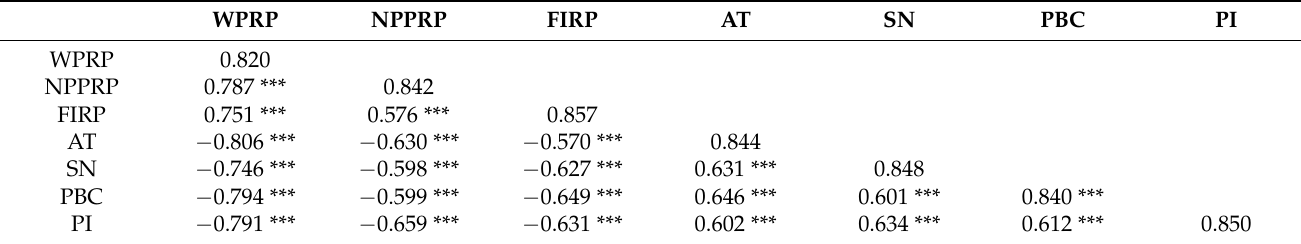
Table 4. Discrimination